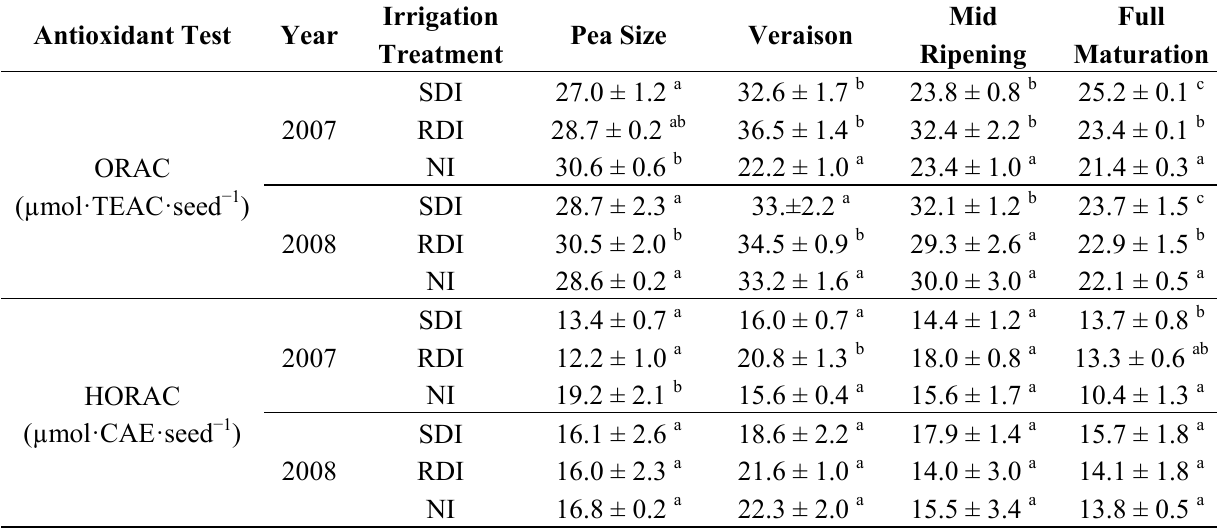
Table 2. Oxygen radical absorbance capacity (ORAC) (µmol·TEAC·seed −1 ) and